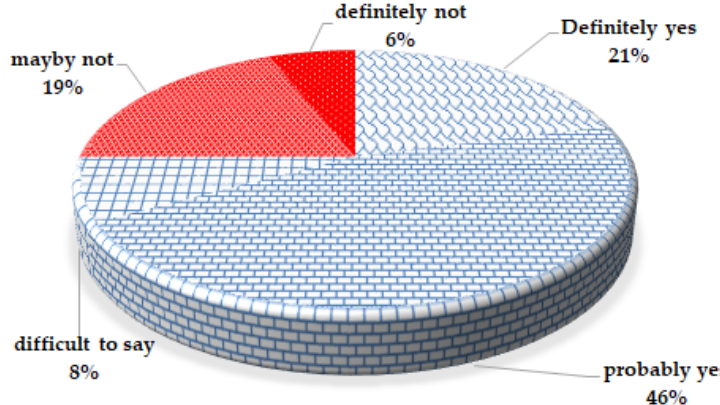
Figure 10. Satisfaction with the long-term use of a personalized product. Source: own study.